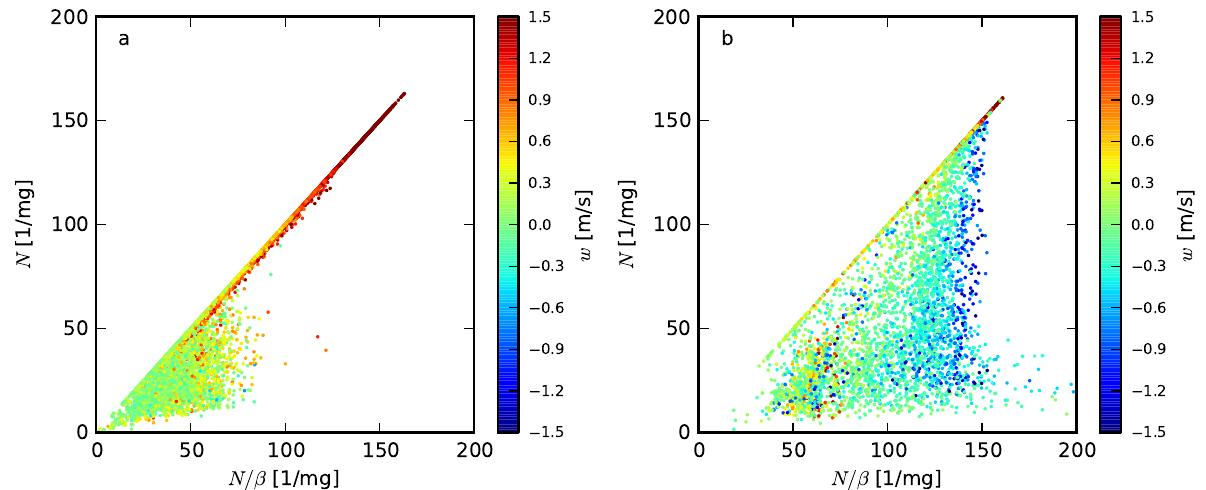
Fig. 11. Scatter diagram of the gridbox mean versus local droplet concentration ( N versus N/β ) for cloudy gridpoint at height of 500m (a) and 1200m (b) . Color marks the vertical velocity, and the color scale is shown to the right of each panel.